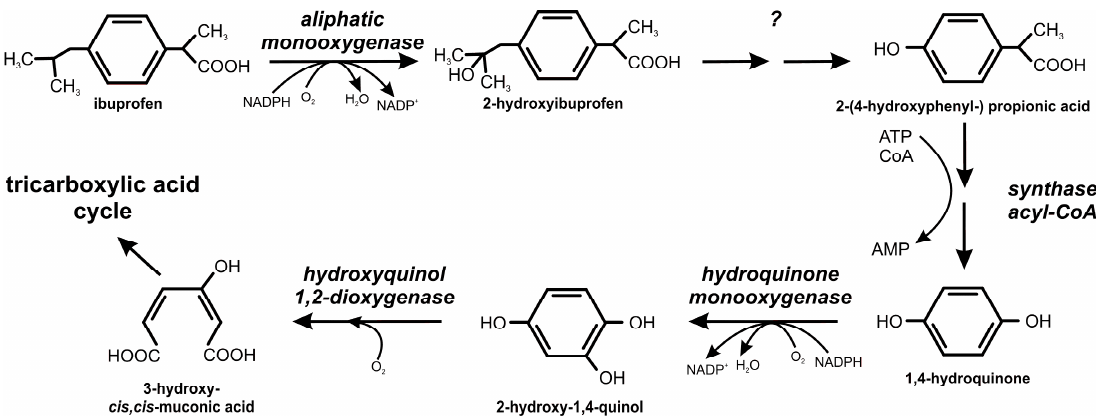
Figure 8. Ibuprofen degradation pathway in Bacillus thuringiensis B1(2015b).